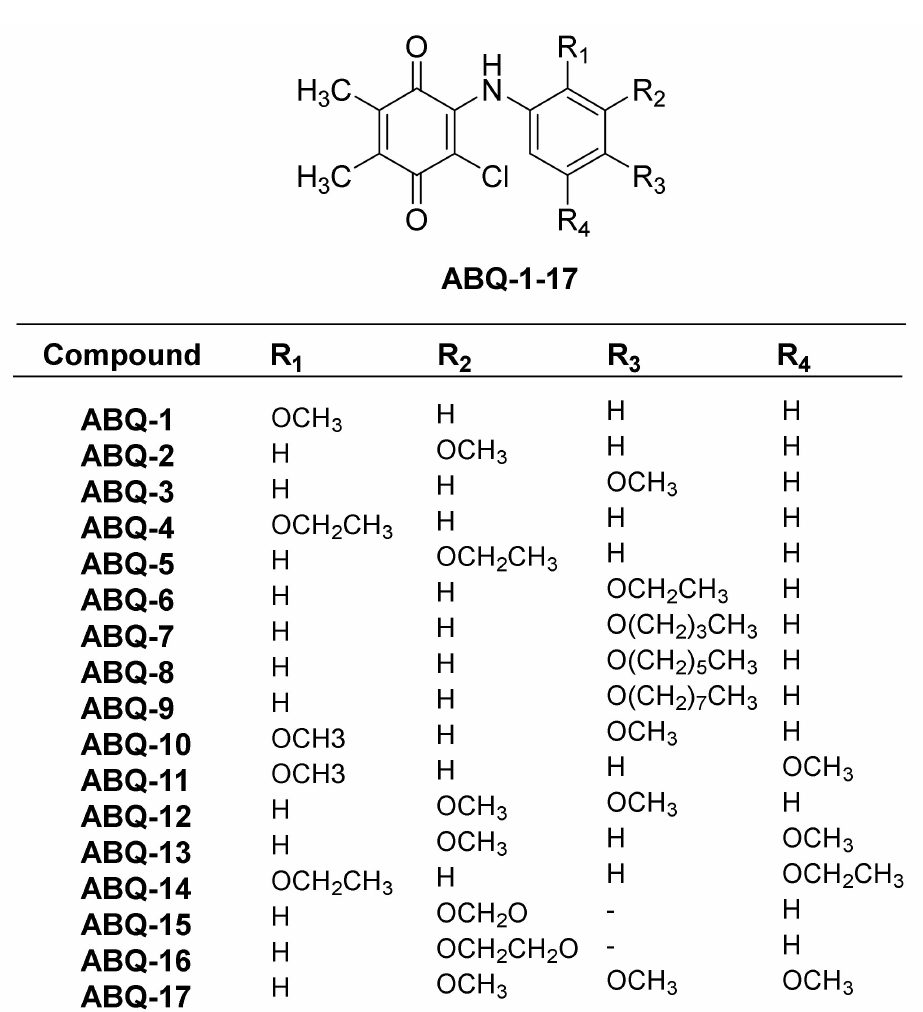
Figure 3. General chemical structure of ABQ-1-17 along with